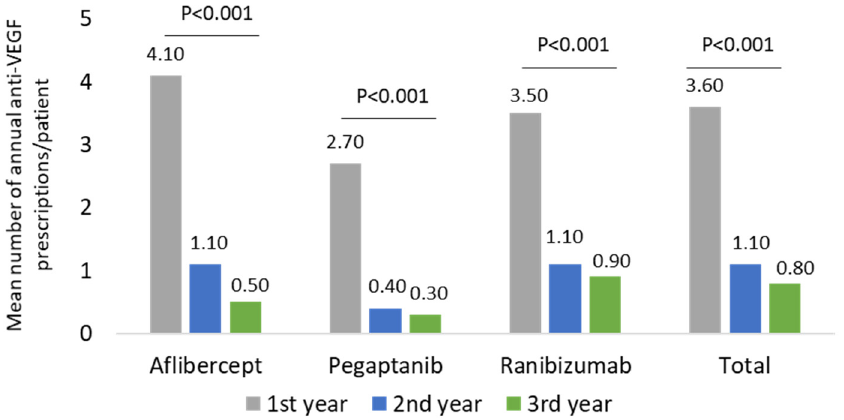
Figure 2. Mean number of annual anti-VEGF prescriptions/patient during the follow-up among the wAMD-cohort.